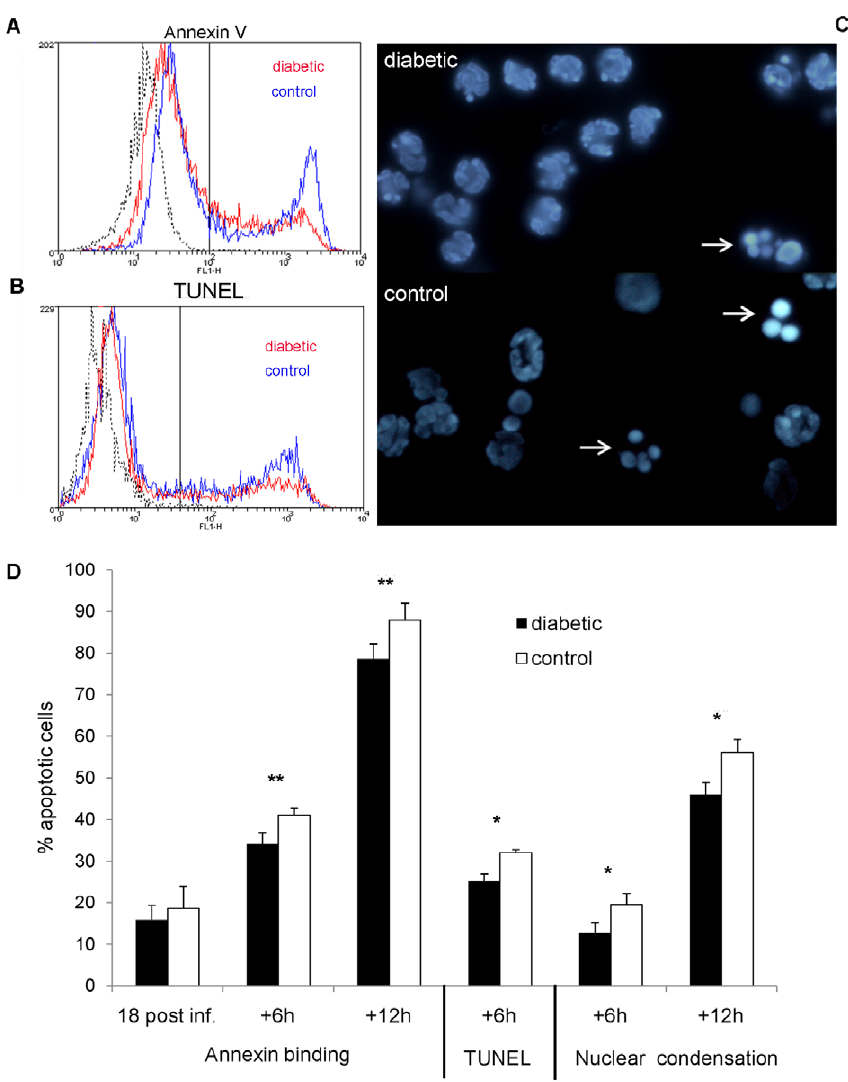
Figure 4. Neutrophil apoptosis— invivo infection. Neutrophils were isolated from the peritoneal cavities of mice 18 h after IP challenge with 10 8 CFU S. aureus and evaluated immediately or after incubation ex vivo for 6 or 12 h. A) Representative flow cytometric analysis of annexin V binding (A) or TUNEL staining (B) of Ly6G + neutrophils from NOD mice that had been incubated ex vivo for 6 h. Black line represents unstained neutrophils. (C) Nuclear condensation observed in neutrophils from a diabetic and a nondiabetic mouse 6 h after isolation. White arrows indicate condensed and fragmented nuclei. (D) Quantitative comparison of annexin binding, TUNEL staining and nuclear condensation of neutrophils from age-matched diabetic and nondiabetic animals reveals that neutrophils from diabetic mice show reduced apoptosis compared to neutrophils from nondiabetic mice. Mean percent apoptotic cells 6 SEM from 4 to 6 independent experiments are depicted. P values are calculated from pair-wise comparisons of age-matched mice; * indicates P , 0.05, ** P , 0.01.